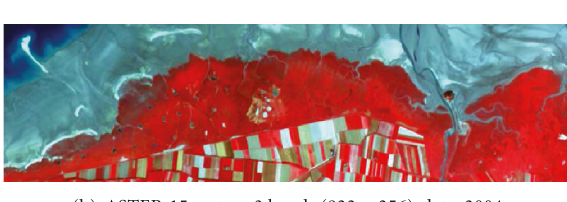
Figure 16: Corresponding clusters between two clustering meth- ods, in grey the agreement, in black the